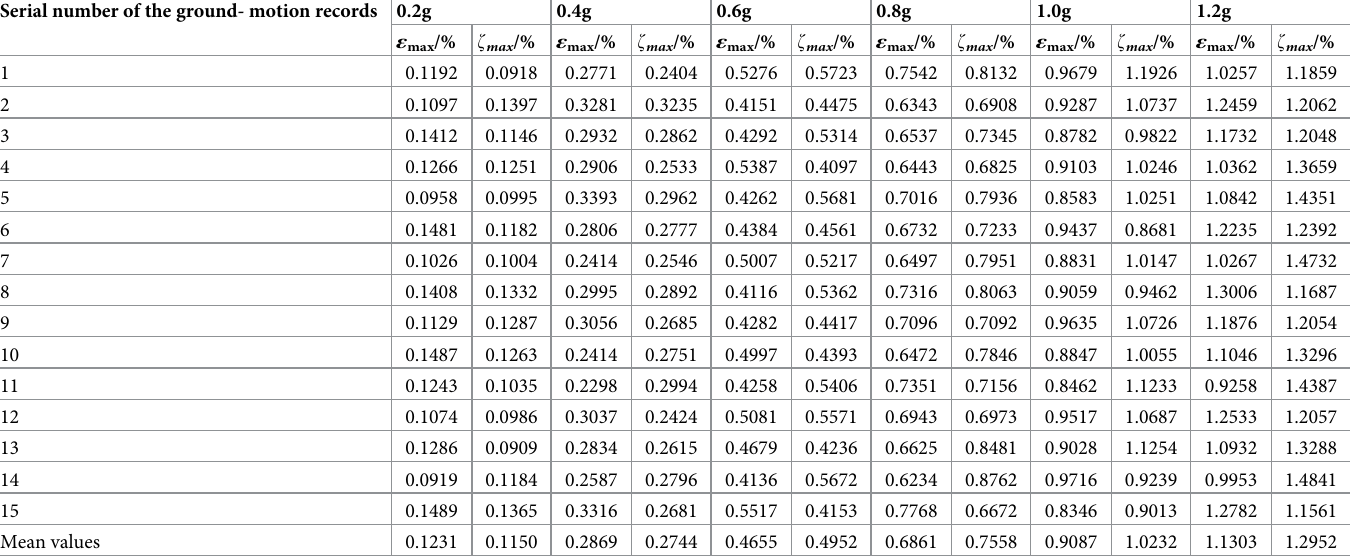
Table 5. Dynamic response analysis results of the embankment fill-soil foundation-retaining wall system. Serial number of the ground- motion records 0.2g